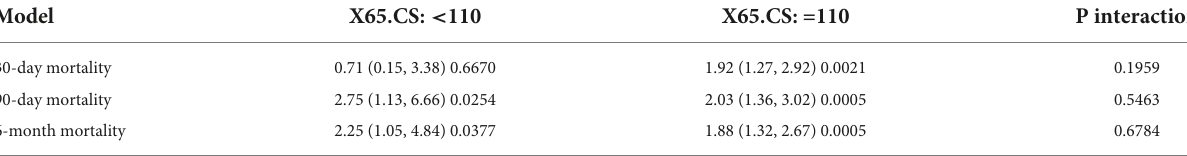
TABLE 4 The interaction analyses using creatinine as effect